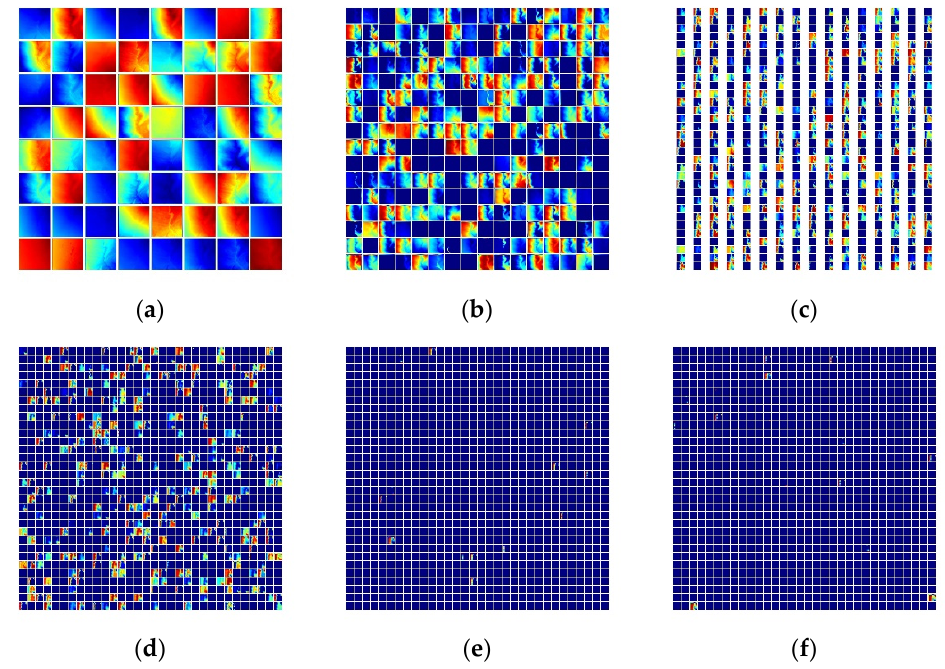
Figure 11. Feature map of ResNet; ( a ) conv1, ( b ) layer1, ( c ) layer2, ( d ) layer3, ( e ) layer4_1 and ( f ) layer4_2.